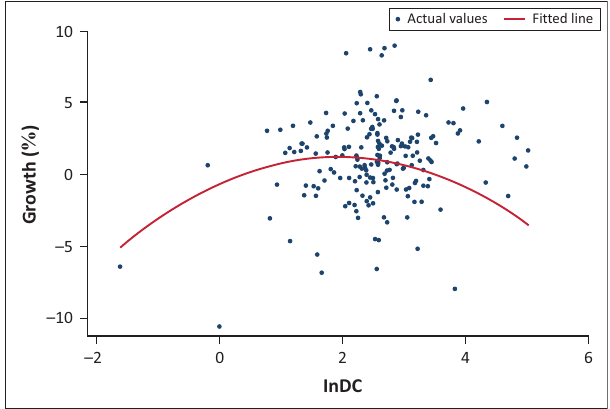
FIGURE 1: Domestic private credit to gross domestic product ratio and growth.